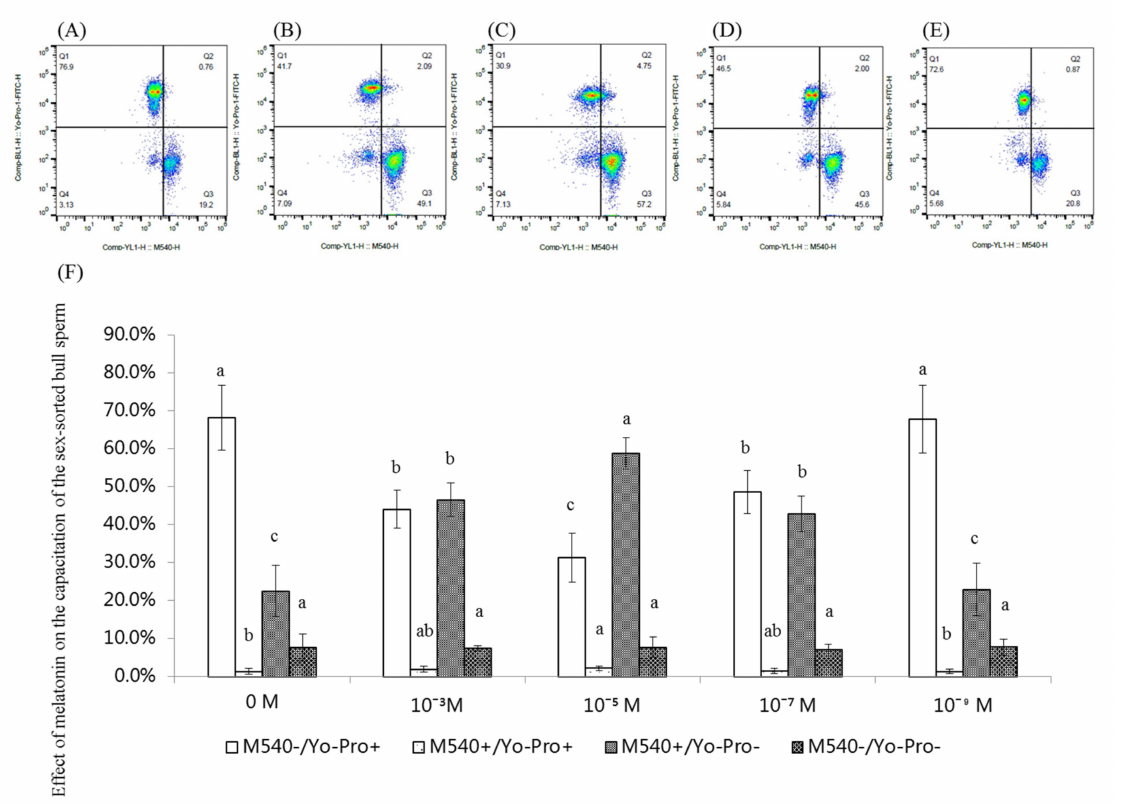
Figure 7. E ff ect of melatonin on sex-sorted bull sperm capacitation. ( A ) Representative image of 0 M group. ( B ) Representative image of 10 − 3 M group. ( C ) Representative image of 10 − 5 M sperm analysis. ( D ) Representative image of 10 − 7 M group. ( E ) Representative image of 10 − 9 M sperm analysis. The quadrants represented viable sperm without destabilized membranes (YoPro − and M540 − ), viable sperm with destabilized membranes (YoPro − and M540 + ), nonviable sperm without destabilized membranes (YoPro − and M540 + ), and nonviable sperm with destabilized membranes (YoPro + and M540 + ). ( F ) E ff ect of melatonin on sex-sorted bull sperm capacitation. Lowercase letters represent statistical significant di ff erence ( p <